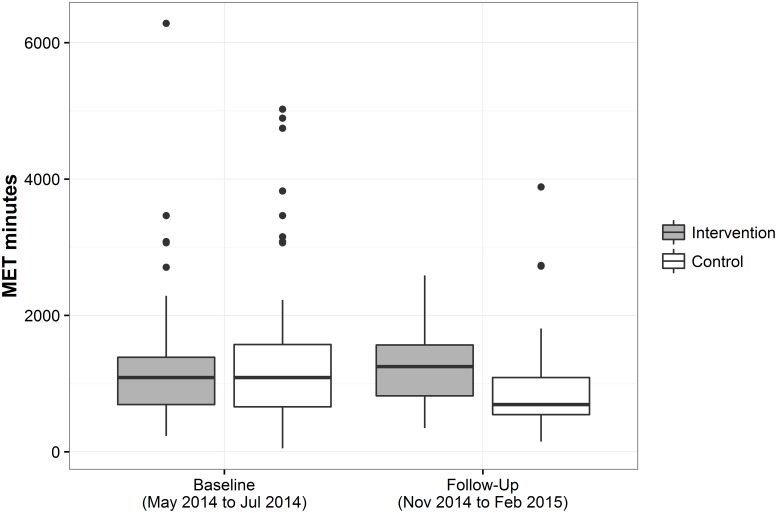
Primary outcome: Energy expenditure (MET minutes per week) in intervention and control groups at baseline (May to July 2014) and six-month follow-up (November 2014 to February 2015).Median values with interquartile range (IQR) are depicted with Tukey boxplots. The upper whisker extends from the hinge to the highest value that is within 1.5 * IQR of the hinge. The lower whisker extends from the hinge to the lowest value within 1.5 * IQR of the hinge. Data beyond the end of the whiskers are plotted as points [33].